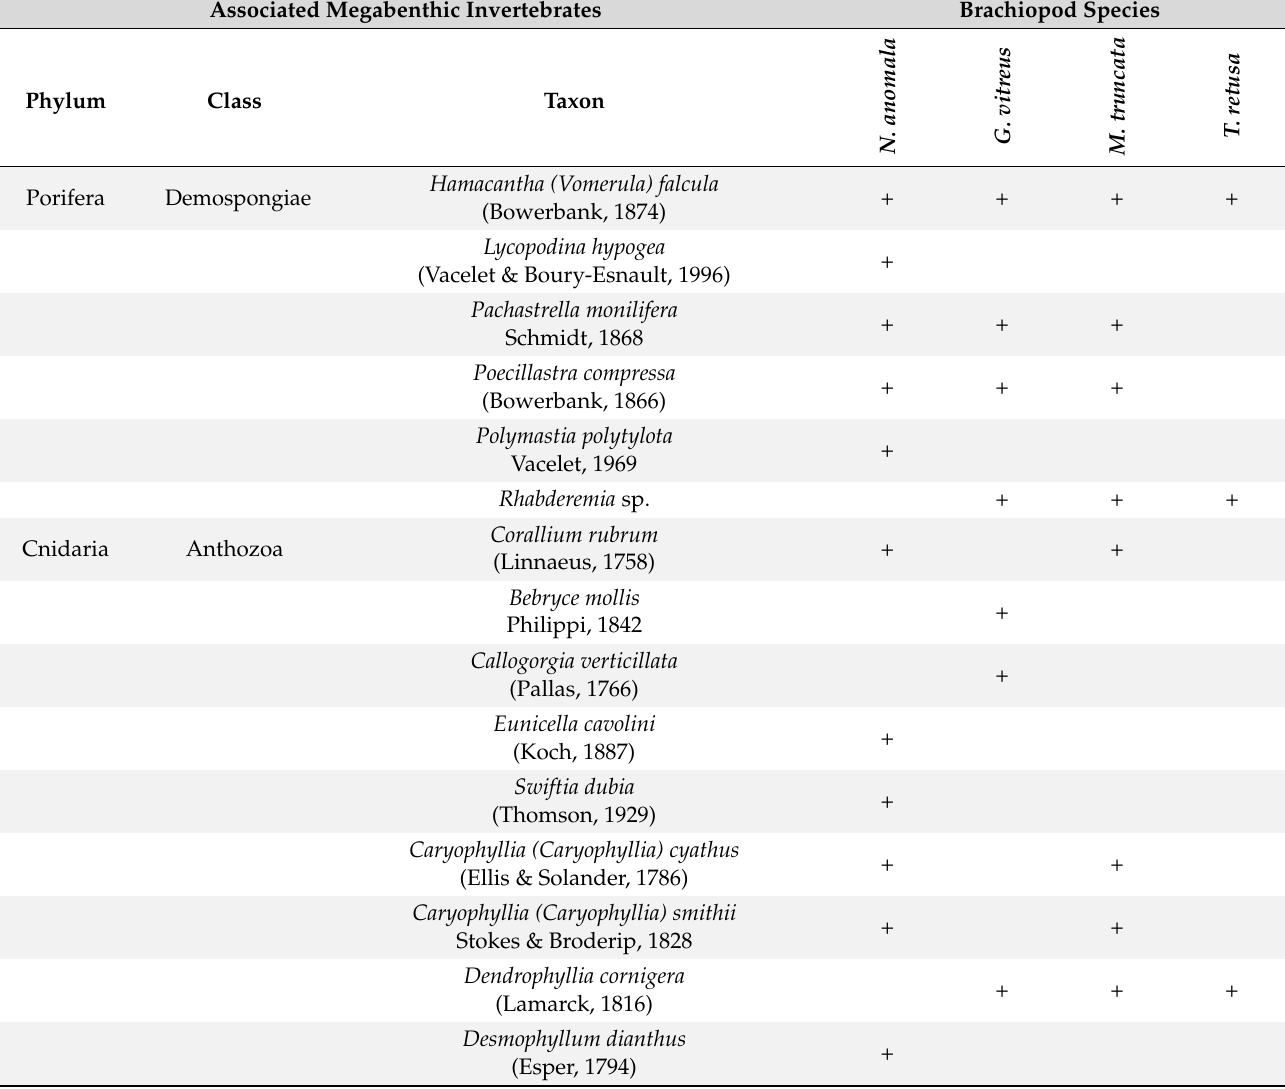
Table 4. List of the megabenthic invertebrate taxa present together or in the proximity of the target